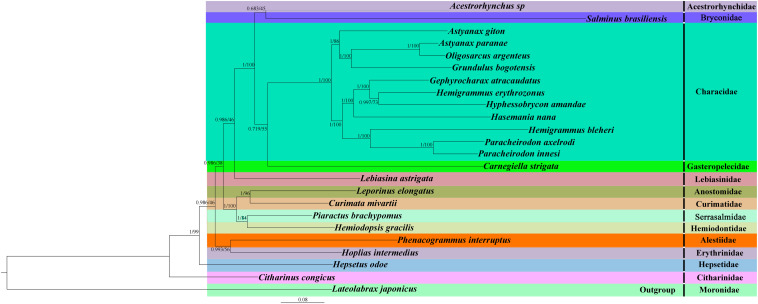
Phylogenetic tree of 24 Actinopterygii species constructed by the Bayesian inference and maximum likelihood methods based on the concatenated sequences of 13 PCGs and two rRNAs. The support values are Bayesian posterior probabilities (left) and bootstrap support values (right), respectively.